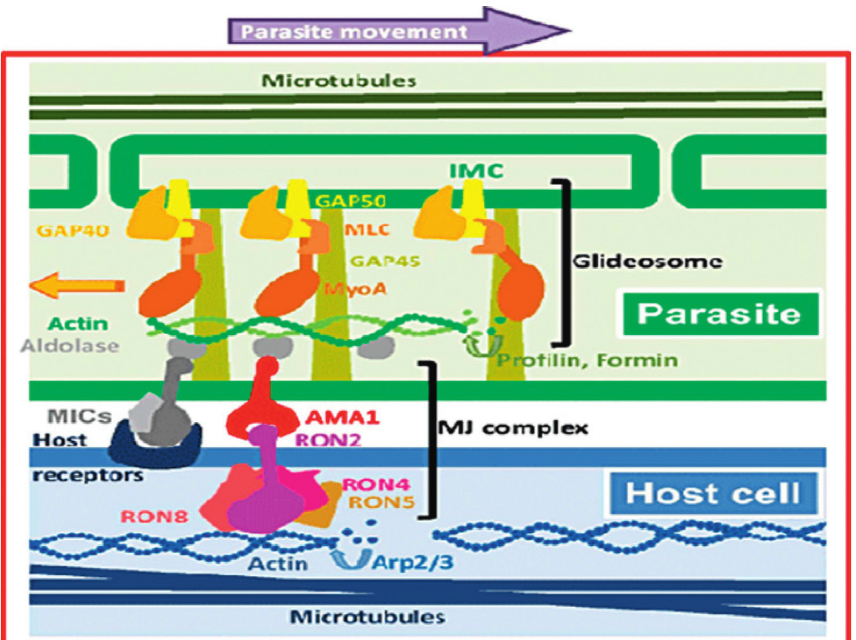
Figure 2: Model of the moving junction complex and glidesome driving gliding motility (GAP: gliding-associated protein, MyoA: myosin A MLC: myosin light chain, and Arp2/3: actin nucleator complex) (adopted from [55]).